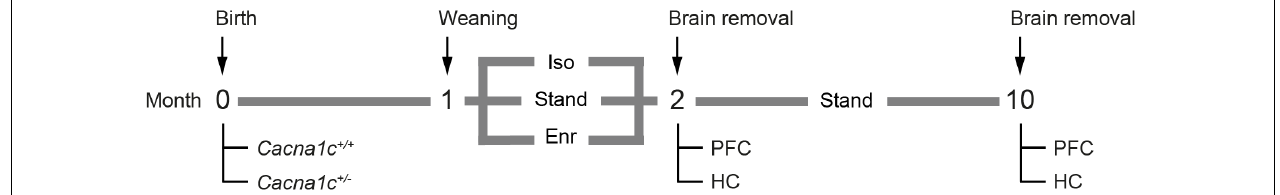
FIGURE 1 | Experimental design. Shortly after birth, the genotypes of the rats ( Cacna1c + / + vs. Cacna1c + / − ) were determined. With 3 weeks of age (PND 21), the rats were separated from their mothers and allocated to one of three experimental housing conditions, i.e., post-weaning social isolation (Iso), standard housing (Stand), and social and physical environmental enrichment (Enr), where they spend 4 weeks before their brains were removed (PND 50 ± 1) and the mitochondria were isolated from the prefrontal cortex (PFC) and the hippocampus